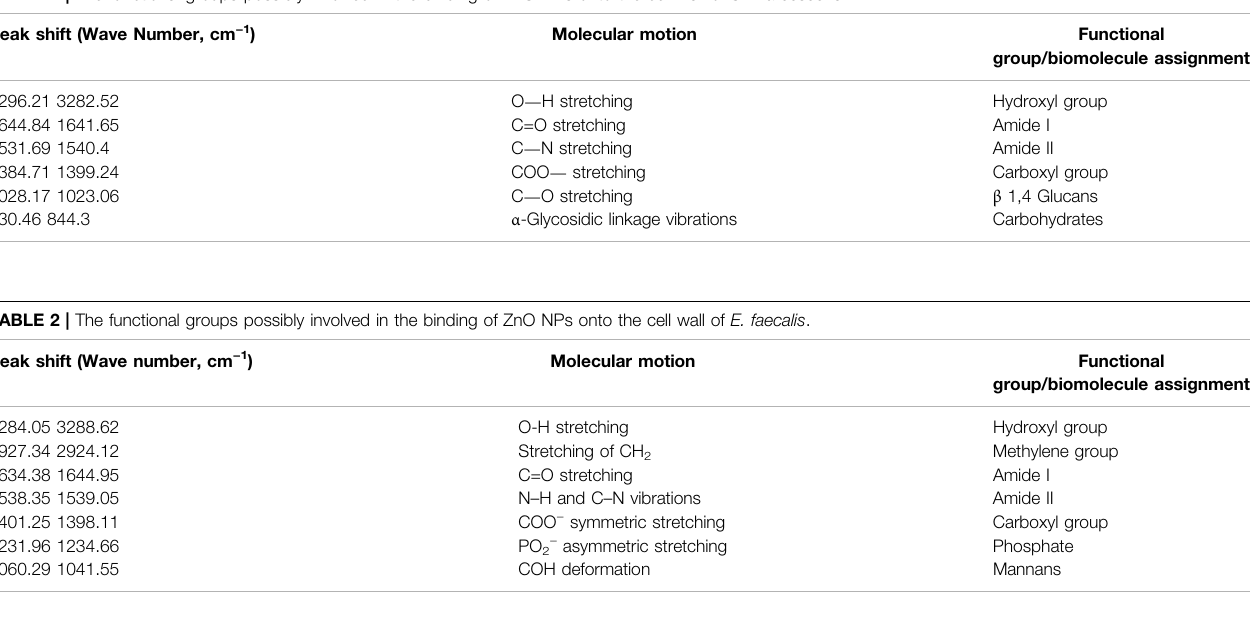
TABLE 1 | The functional groups possibly involved in the binding of ZnO NPs onto the cell wall of S. marcescens . Peak shift (Wave Number, cm − 1 )